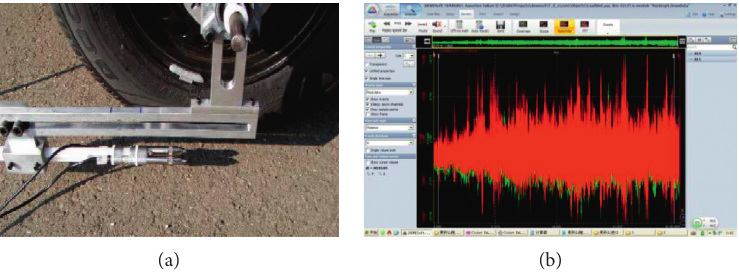
Figure 3: On-board sound intensity (OBSI) method: (a) noise testing system and (b) data acquisition system.